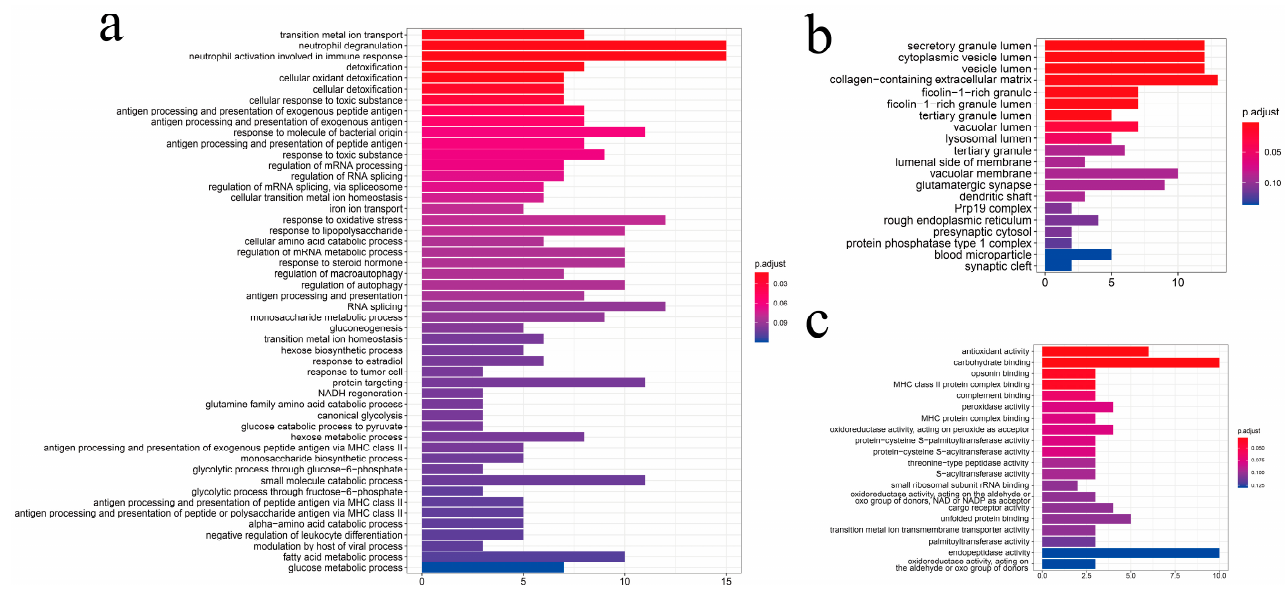
Figure 6. GO enrichment analysis of differentially expressed genes. ( a ) biological processes; ( b ) cellular components; ( c ) molecular functions.